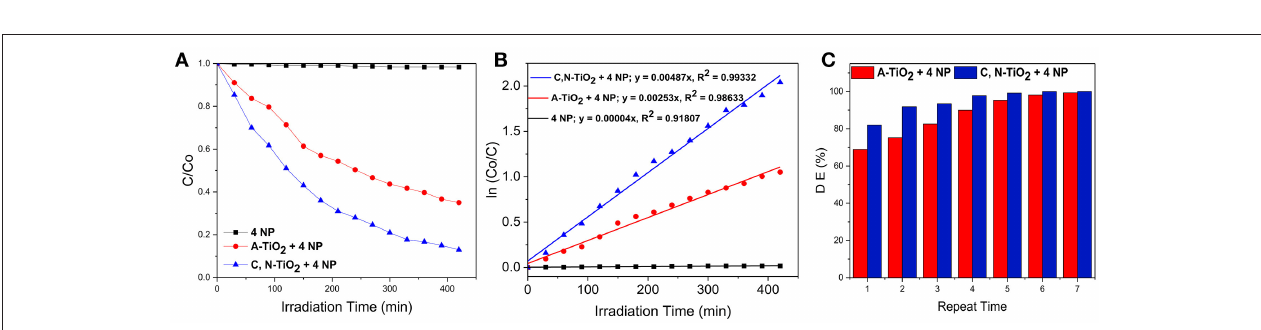
FIGURE 4 | (A) Photocatalytic degradation of 4-nitrophenol. (B) First order kinetic analysis for the 4-nitrophenol degradation over C, N-TiO 2 and A-TiO 2. (C) Degradation of 4-nitrophenol over A-TiO 2 and C, N- TiO 2 after multiple